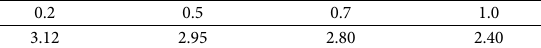
Table 7. Band gap energy of Ni-doped samples heated at 500 ° C.